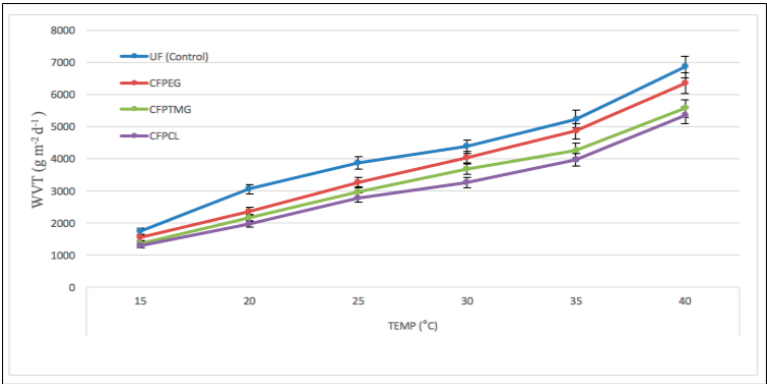
Figure 6. WVT of UF (control), CFPEG, CFPTMG, and CFPCL.